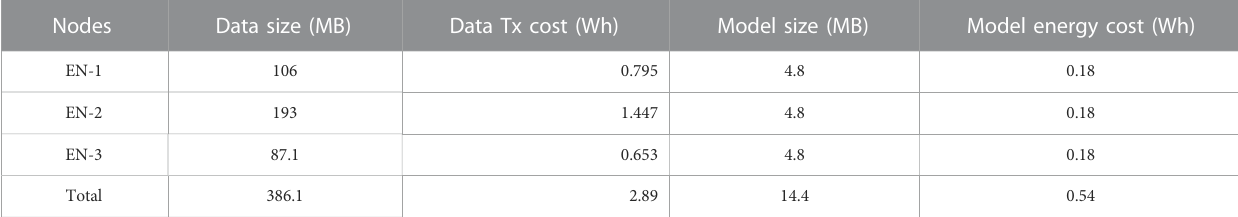
TABLE3Comparisonofcommunicationcostofcentralisedlearningvs.proposedVFWN.Thecommunicationcostiscomputedintermsofaverageelectricalenergy consumption for wireless data transfer in